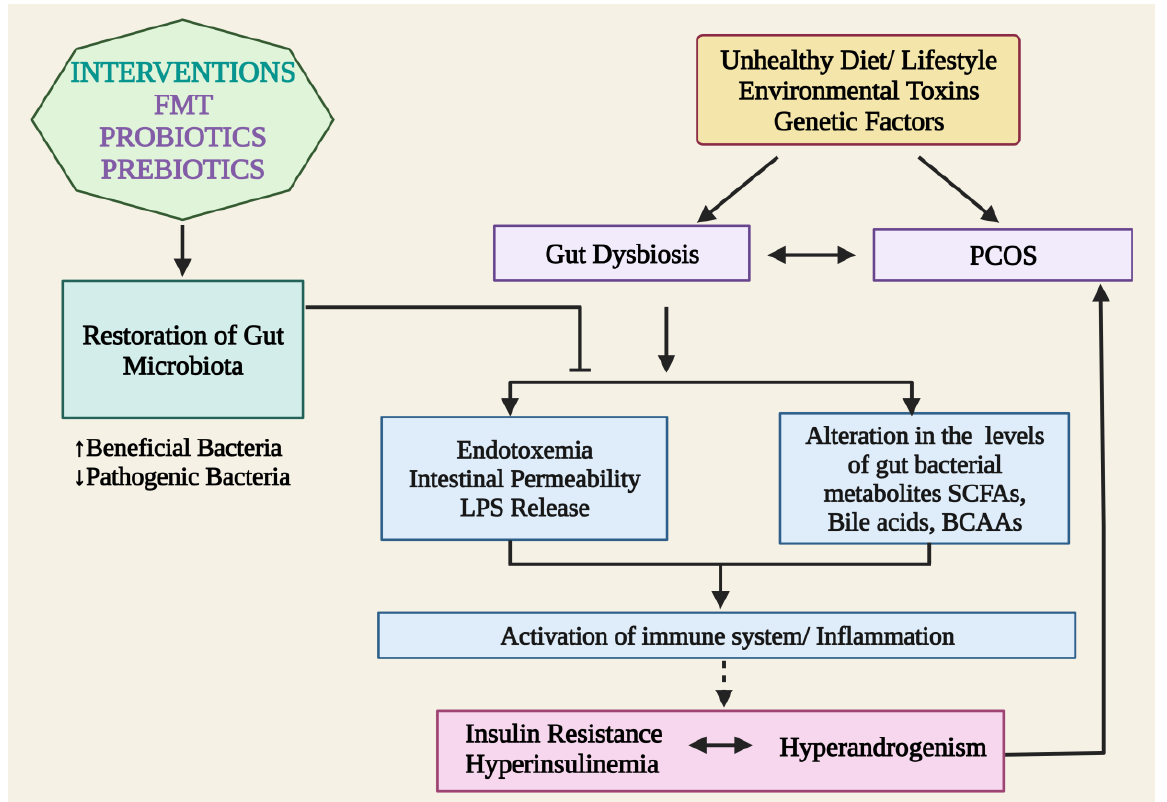
Figure 3. Plausible mechanisms of action of probiotics, prebiotics, and FMTs in restoring gut micro- biota and alleviating PCOS. LPS: lipopolysaccharides; SCFAs: short-chain fatty acids; and BCAAs: branched-chain amino acid and FMTs; Fecal microbiota transplantation.